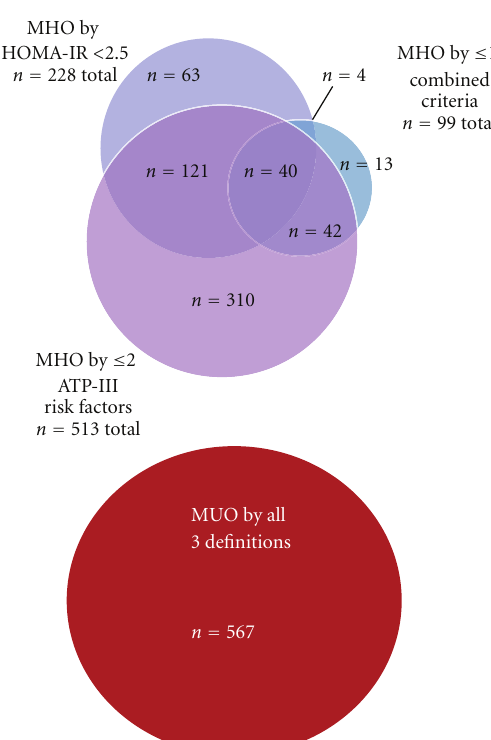
Figure 1: Overlap and uniquely classified obese individuals by three di ff erent metabolic health definitions. For the description of definitions of metabolic health, see Table 1. HOMA-IR, homeostasis model assessment-insulin resistance; ATP-III, Adult Treatment Panel III; MHO, metabolically healthy obese; MUO, metabolically unhealthy obese. Obese participants, n =